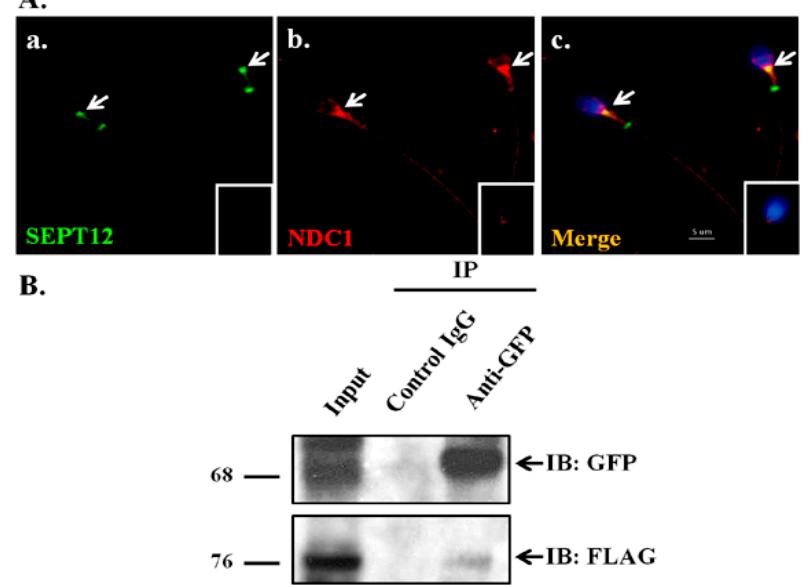
Figure 1. Colocalization and interaction between SEPT12 and NDC1. ( A ) Immunofluorescence detection in a mature human spermatozoon of ( a ) SEPT12; ( b ) NDC1; and ( c ) merged SEPT12 and NDC1. White arrows indicate the centrosome regions of the sperm. Insets reveal control IgG staining. Scale bar = 5 μ m; ( B ) coimmunoprecipitation assay of FLAG-NDC1 and SEPT12-GFP. Lysates from transfected cells were immunoprecipitated with an anti-GFP antibody (Lane 3) or a nonspecific control IgG (Lane 2), followed by IB with an anti-GFP (indicated by black arrow) or anti-FLAG antibody (indicated by black arrow). An input protein (5%) was used as the control in IB of the transfected cell lysates (Lane 1).